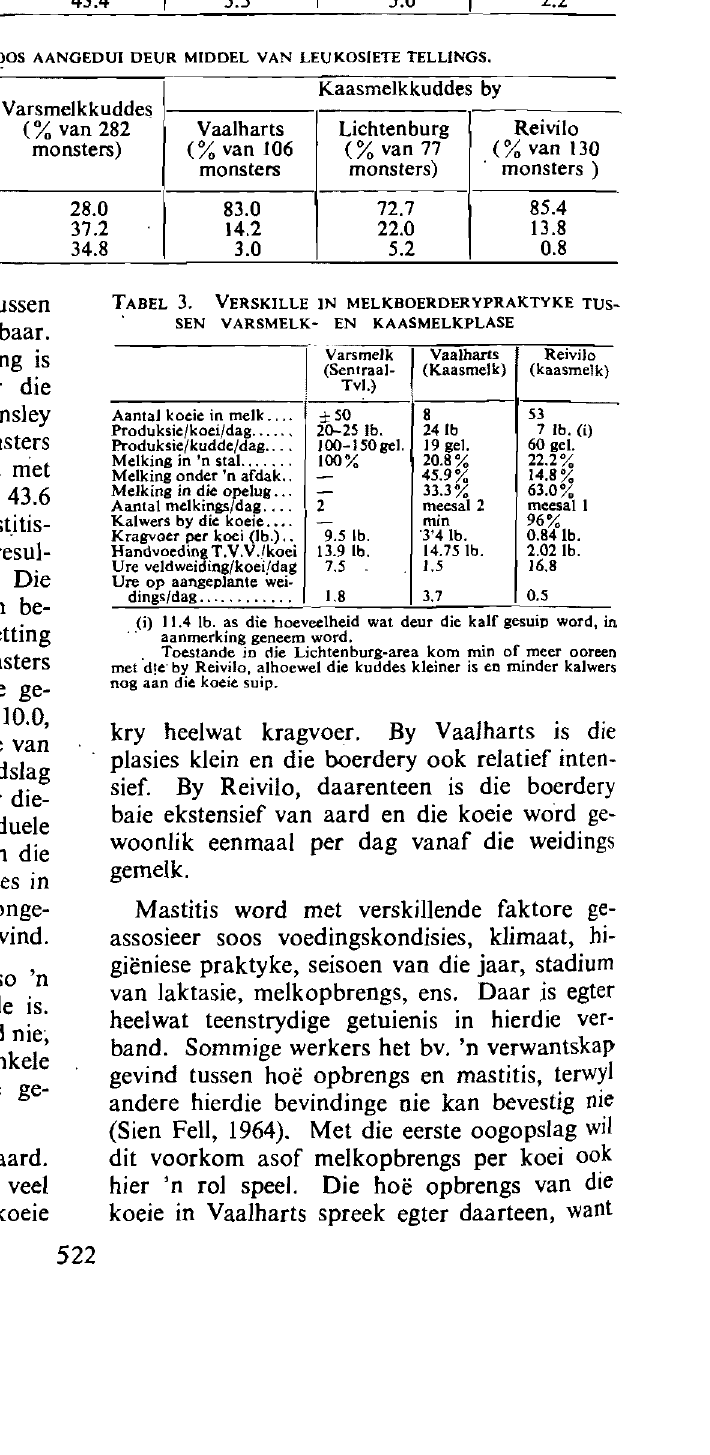
Kaasmelkkuddes by Varsmelkkudd.es